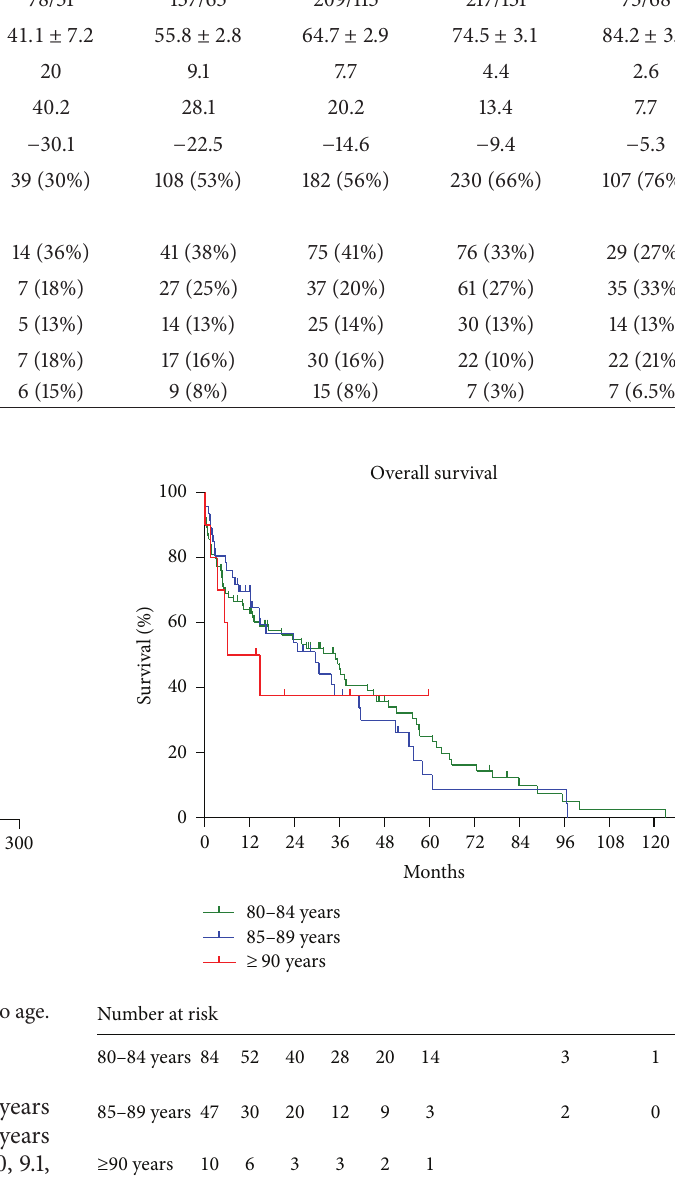
Figure 3: Overall survival in 144 dialysis patients aged ≥ 80 years. The median survivals in the age groups of 80–84, 85–89, and > 90 years were 3.0, 2.5, and 0.9 years, respectively. There were no significant differences in survival among the